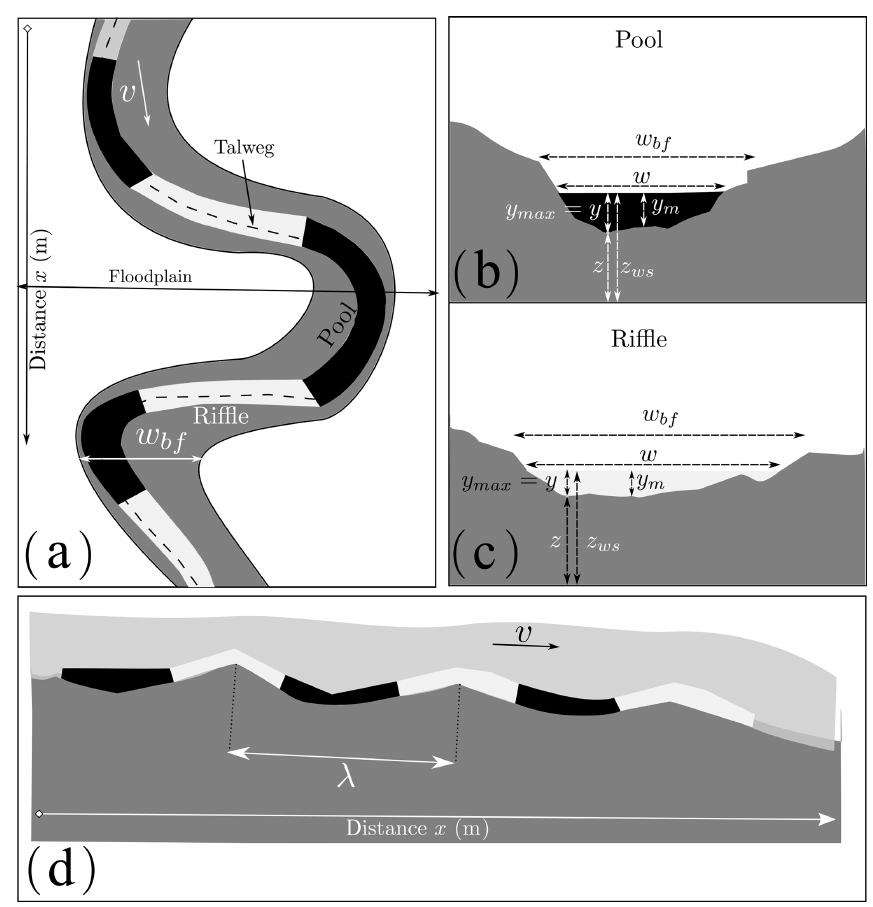
Figure 1. Different views of pool–riffle sequences. (a) Plan view pattern that includes bankfull width w bf , floodplain extent, talweg line, velocity v , pools and riffles, and channel direction (planform); (b) cross-sectional view of a pool with a section width w and a steeper water depth y calculated from the talweg elevation, which is the deepest part of the bottom, and y = y max = z ws − z , with z the bed elevation, z ws the water surface elevation, and y m the mean water depth; (c) cross-sectional view of a riffle with a shallower water depth y , higher bed elevation z and high bankfull width w bf ; (d) longitudinal profile that makes it possible to see the water surface, the bed slope, the pools and riffles, and the wavelength λ calculated between two successive riffles or